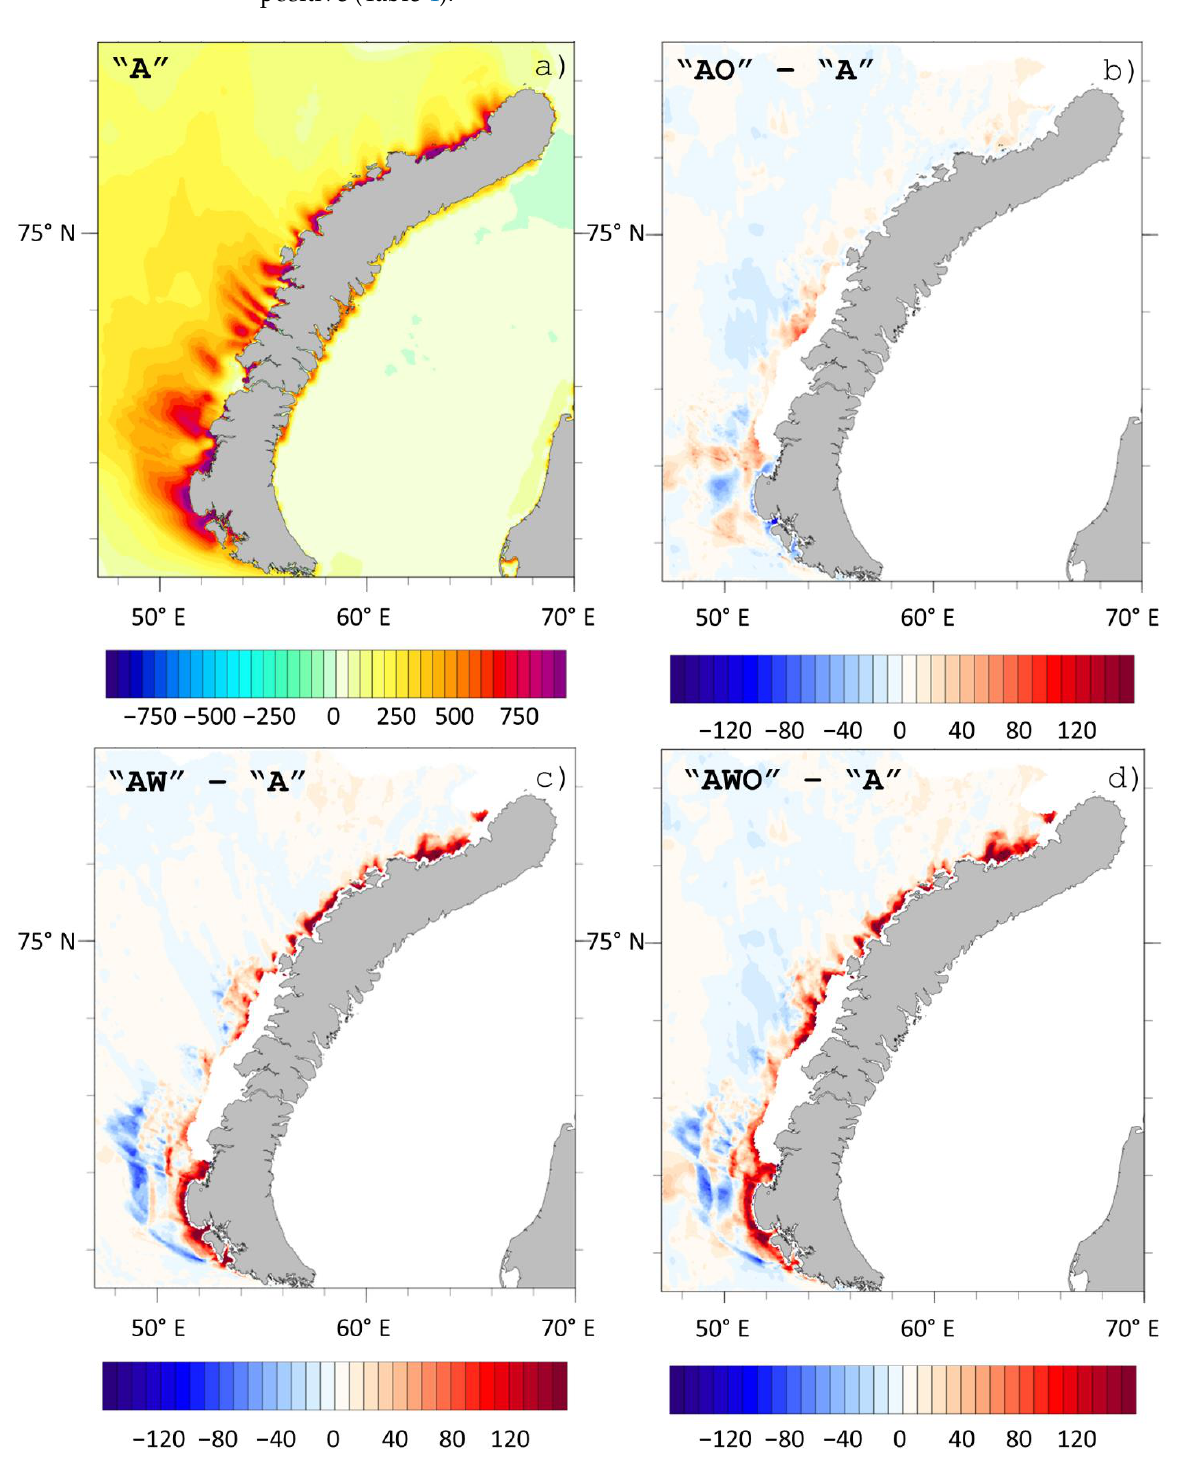
Figure 6. Total turbulent heat flux (W m −2 ) in experiment “A” ( a ) and difference in heat fluxes (W m −2 ) between coupled experiments “AO” ( b ), “AW” ( c ), “AWO” ( d ) and uncoupled experiment “A” averaged over the bora period (10 – 12 December ). Areas with sea ice from experiment “A” in ( b – d ) are shaded in white.